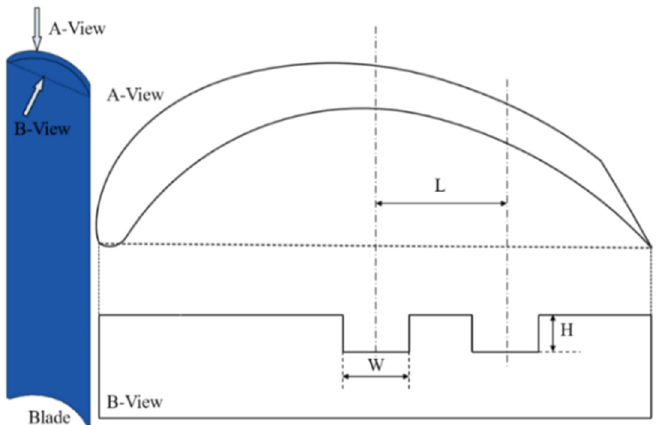
Figure 8. Basic parameters of bionic